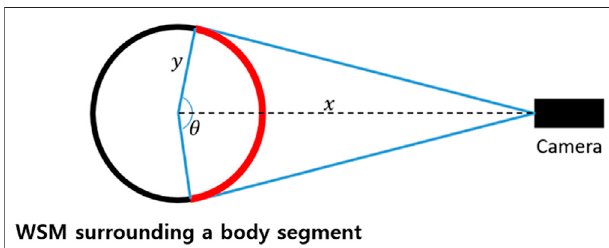
FIGURE 2 | The number of pattern IDs needed for a WSM was decided by considering that at least two pattern IDs should be visible in the red region, thereby ensuring that at least one pattern ID can be recognized from any